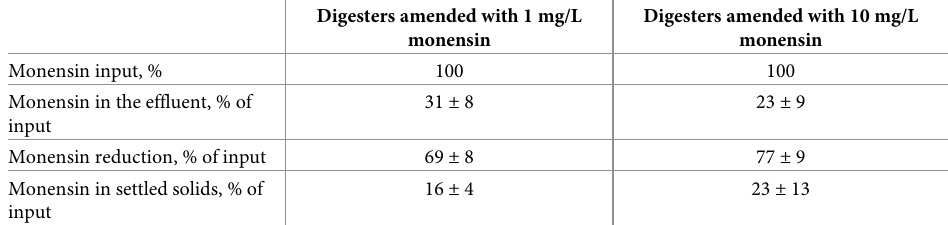
Table 4. Mass balance of monensin (mean ± std. dev.) in digesters containing monensin-amended